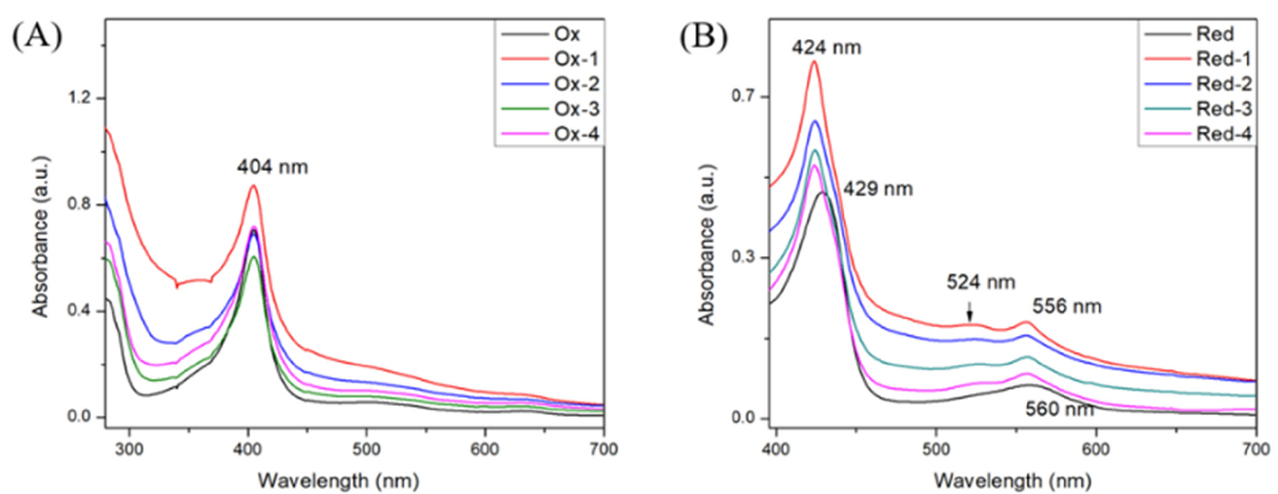
Figure 3. UV–vis spectral analysis of IDO1 and upon the binding of inhibitors. ( A ) UV–vis spectra of IDO1 in the ferric forms with 100 μ M concentration of different inhibitors; ( B ) UV–vis spectra of IDO1 in ferrous forms with 100 μ M concentration of different inhibitors.